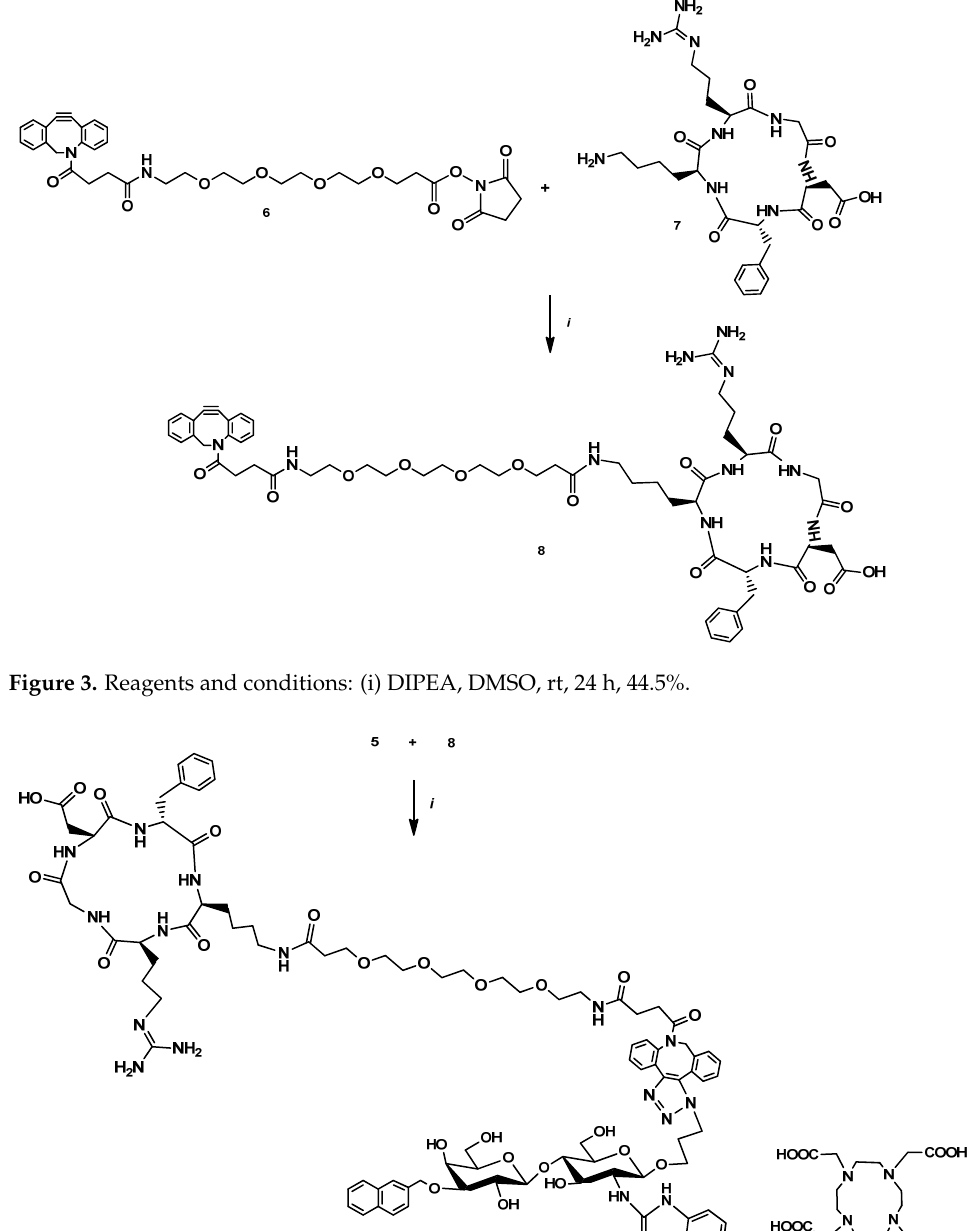
Figure 4. Reagents and conditions: (i) DMSO, rt, 24 h, 24.5%.